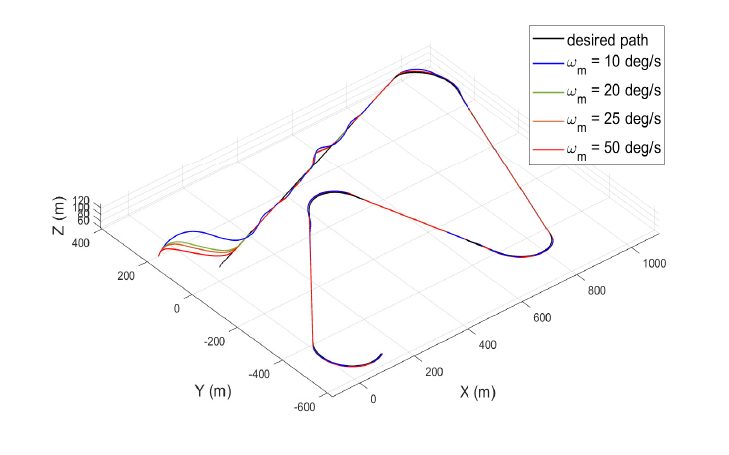
Figure 10. Tracking histories conducted by CSMC according to the angular rate limit